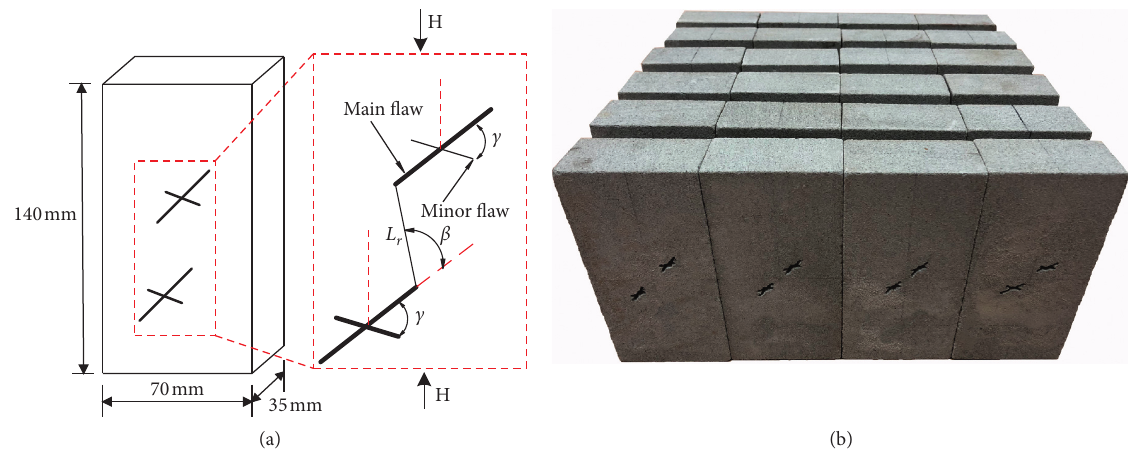
Figure 3: Specimens with cross-flaws: (a) schematic sketch of the flaw geometry in sandy mudstone specimens and (b) sandy mudstone specimens with prefabricated flaws.